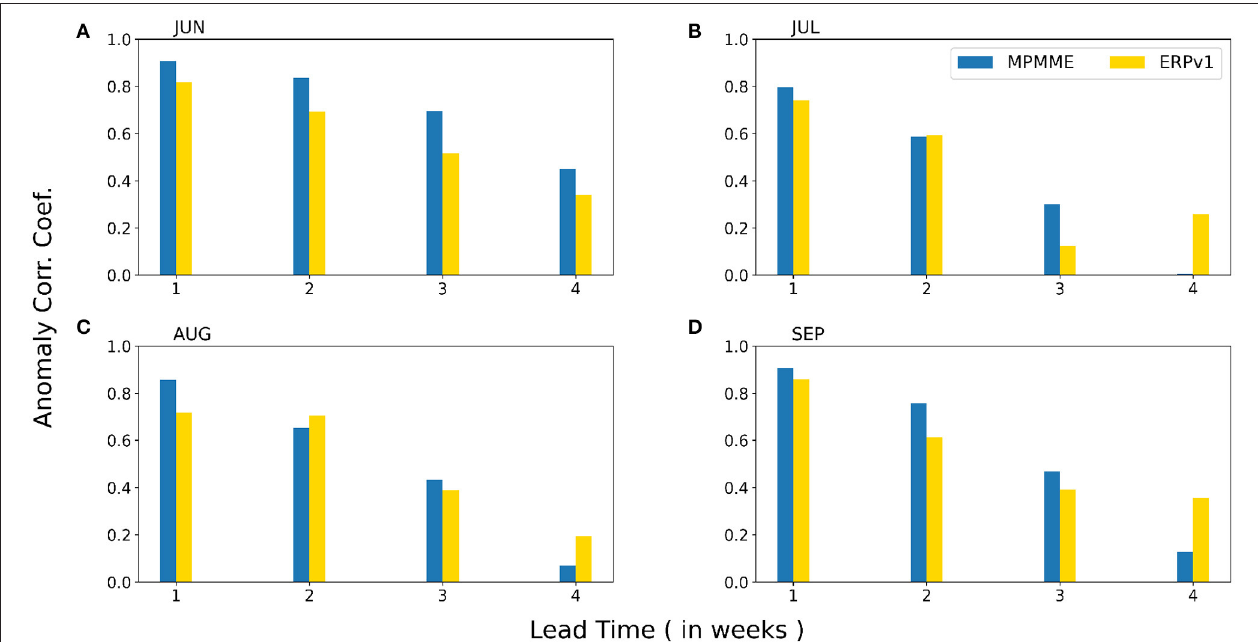
FIGURE 2 | Anomaly correlation coefficient for weekly mean rainfall over monsoon zone of India for the month of (A) June, (B) July, (C) August, and (D) September at four week leads.